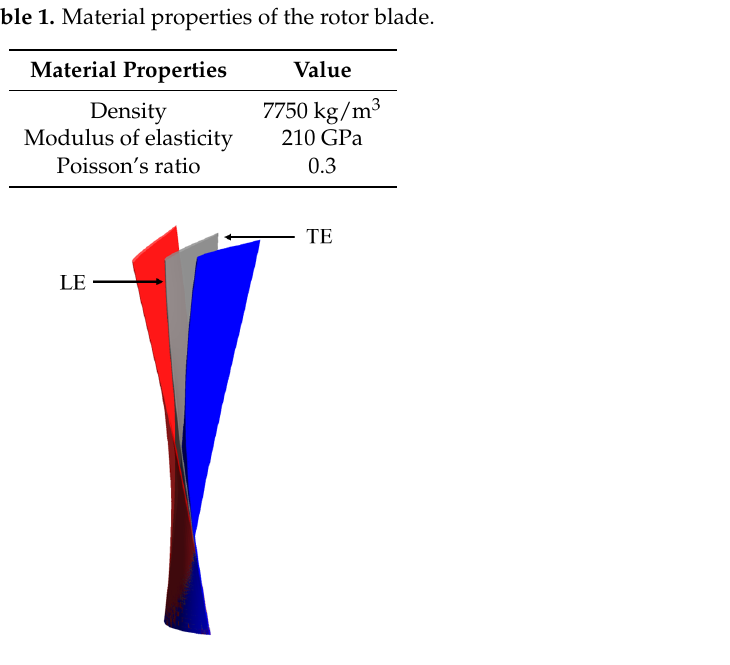
Figure 2. The first flap mode shape of the KTH Steam Turbine Flutter Test Case magnified by a factor of fifty. LE: the leading edge; TE: the trailing